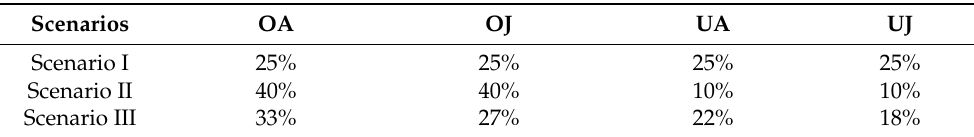
Figure 8. Measurements of the laboratory indices LI 1–3 applied on the laboratory data. By using a threshold value (LI 1: 7.6, LI 2: –16.5, LI 3: 1.8), the laboratory indices can be used to distinguish between healthy and infested spruce samples of particular positions. While LI 1 ( a ) and LI 2 ( b ) misclassify T5 UA and T5 UJ, LI 3 ( c ) can classify all samples correctly. The particular positions of the sample spruces ( d ) are also visible in Figure 3. The laboratory indices are defined in Table 2. Table 3. Percentage distribution of the averaging scenarios. The scenarios represent assumptions about the spatial distribution of needles from a nadir perspective. The scenarios are used to calculate mean values from the laboratory data for the sample spruces (T1–5). (OA = upper canopy layer, old; OJ = upper canopy layer, young; UA = lower canopy layer, old; UJ = lower canopy layer, young) (see Figures 3 and